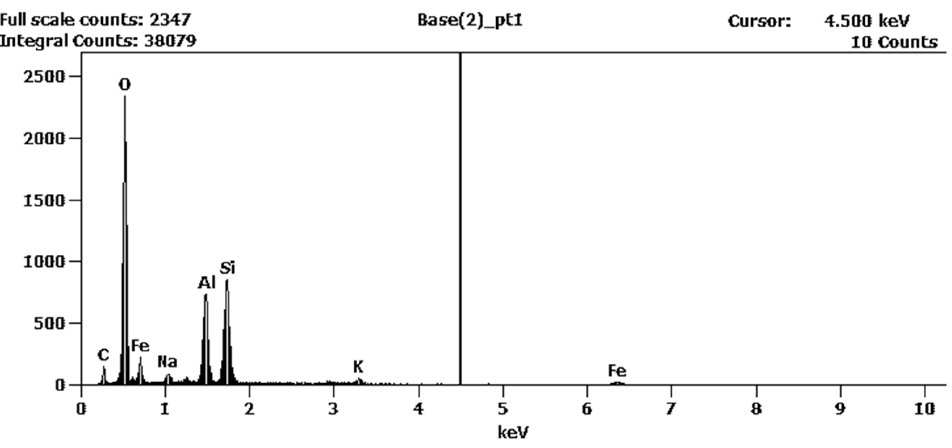
Figure 11. Steel sample surface after the wear tests; 1—aggregates of clay coal abrasive material.